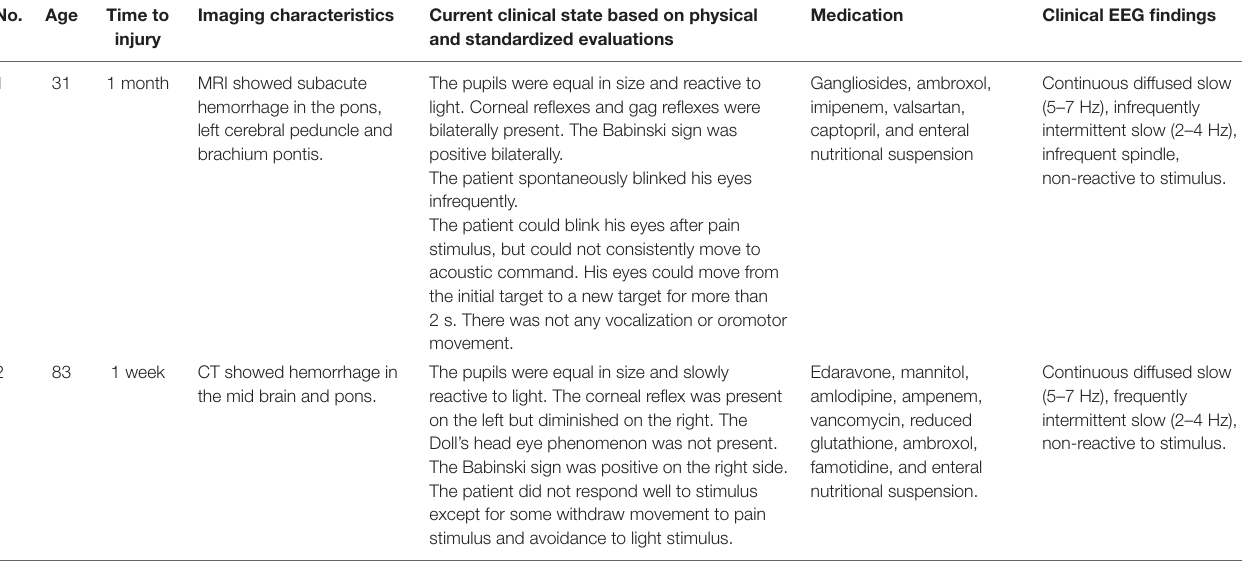
TABLE 1 | Detailed demographics, clinical data, and EEG analysis results of the two patients studied. No.